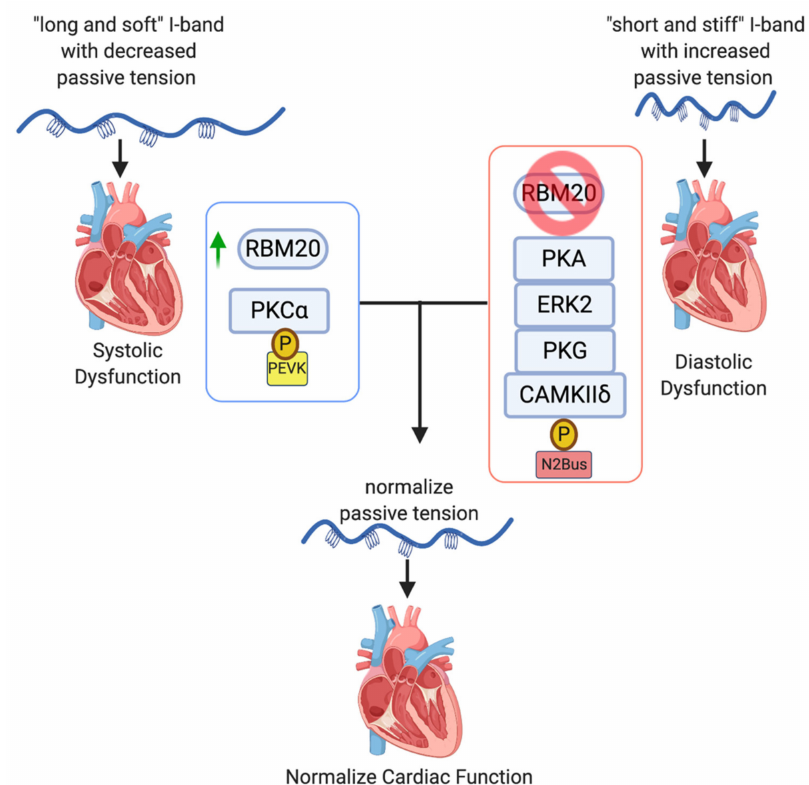
Figure 5. Transcriptional and post-translational modifications of titin alter passive tension and serve as therapeutic targets for treatment of heart failure. Patients with systolic dysfunction have decreased passive sti ff ness of the ventricle. Modifications of titin by upregulation of RNA binding motif protein 20 (RBM20) and preferencing the N2B isoform, or phosphorylation of the PEVK element can increase passive tension of the I-band and may improve cardiac function. Conversely, patients with diastolic dysfunction have increased passive tension of the ventricle. Decreased expression of RBM20 leading to increased expression of the N2BA isoform, or phosphorylation of the N2Bus element may decrease passive tension and improve cardiac